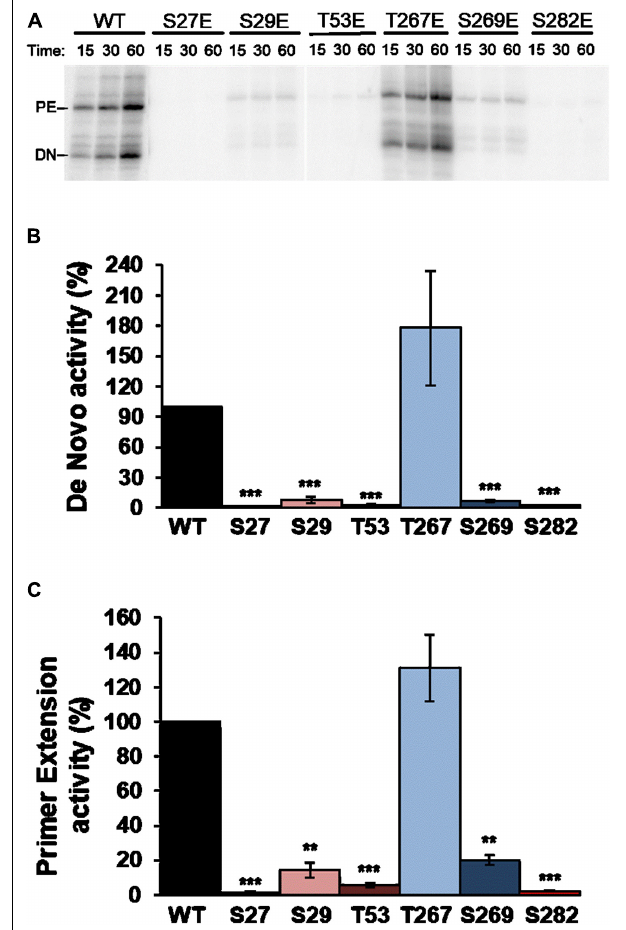
FIGURE 5 | Elongation of LE19 oligonucleotide by de novo initiation and primer extension of NS5B Glu mutants. (A) Representative experiment showing products obtained by primer extension (PE) and de novo initiation (DN) by NS5B WT and mutants imitating phosphorylation (Glu) of residues S27, S29, T53, T267, S269, and S282, using LE19 RNA as a template. Recombinant proteins used are indicated at the top. Quantitative analysis of RNA-dependent RNA polymerase de novo (B) and primer extension (C) activity products at 60 min quantified as described in Figure 4 . The mutated residue (Glu mutant) corresponding to each bar is shown at the bottom. Values in (B,C) are the averages (normalized to WT) and corresponding Standard Errors of the Mean (SEM) from at least four independent experiments. Statistically significant differences (Student’s t -test) are represented as follows: ** p < 0.005; *** p < 0.0005. Asterisks over the bar indicate the p -value comparing to